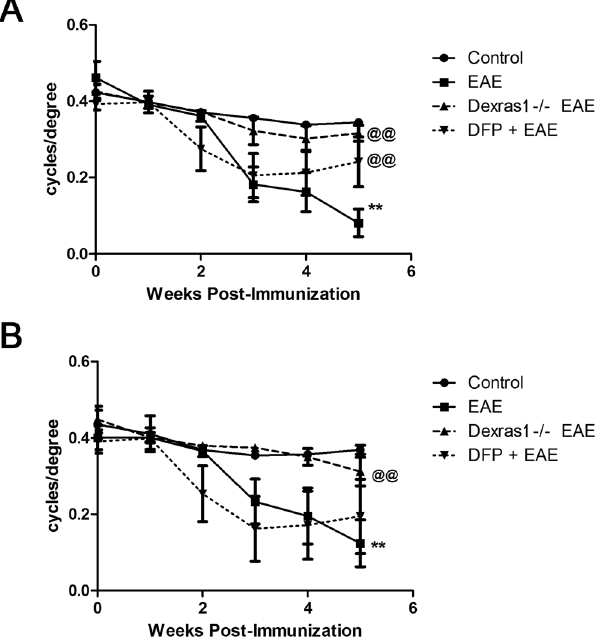
Figure 3. Dexras1 deletion or iron chelation preserves vision. Visual function, measured in both eyes ( A ) by weekly OKR responses, shows significant ( ** p < 0.01) decrease in eyes of EAE mice (N = 10 eyes of 5 mice) compared to control mouse eyes (N = 10 eyes of 5 mice) by 5 weeks after induction of EAE. Dexras1 KO mice (N = 10 eyes of 5 mice) and daily treatment with iron chelator DFP (1 mg/mL, N = 8 eyes of 4 mice) from days 0 to 42 post immunization leads to significantly ( @@ p < 0.01 versus wild-type EAE) improved OKR responses in EAE mice. Visual function, measured by weekly OKR responses in the right eye only ( B ) from the same mice shown in A, shows significant ( ** p < 0.01) decrease in eyes of EAE mice (N = 5 eyes) compared to control mouse eyes (N = 5) by 5 weeks after induction of EAE. Dexras1 KO mice (N = 5 eyes) show significantly ( @@ p < 0.01 versus wild-type EAE) improved OKR responses and daily treatment with iron chelator DFP (N = 4 eyes) shows a trend towards increased OKR